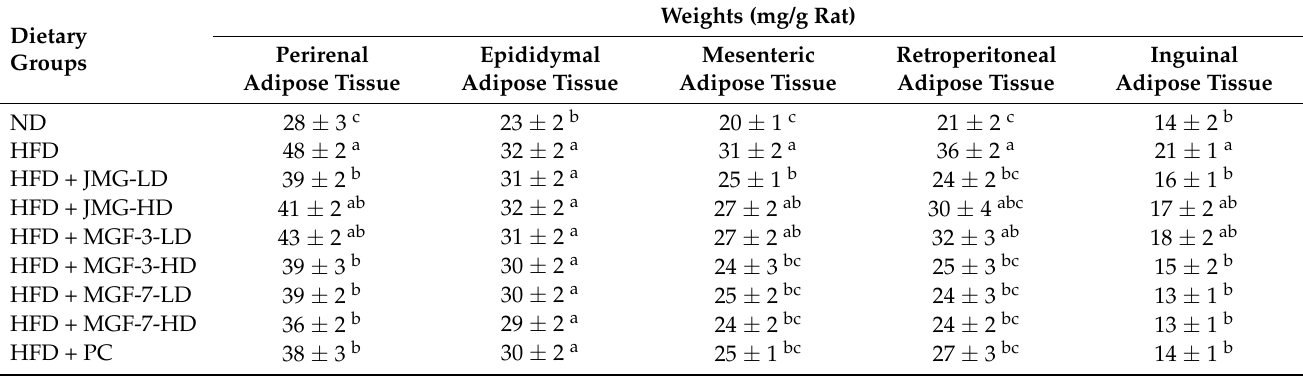
Table 4. Effects of Mei-Gin formulas on the weights of perirenal adipose tissue, epididymal adipose tissue, mesenteric adipose tissue, retroperitoneal adipose tissue, and inguinal adipose in high-fat diet-induced obese rats.